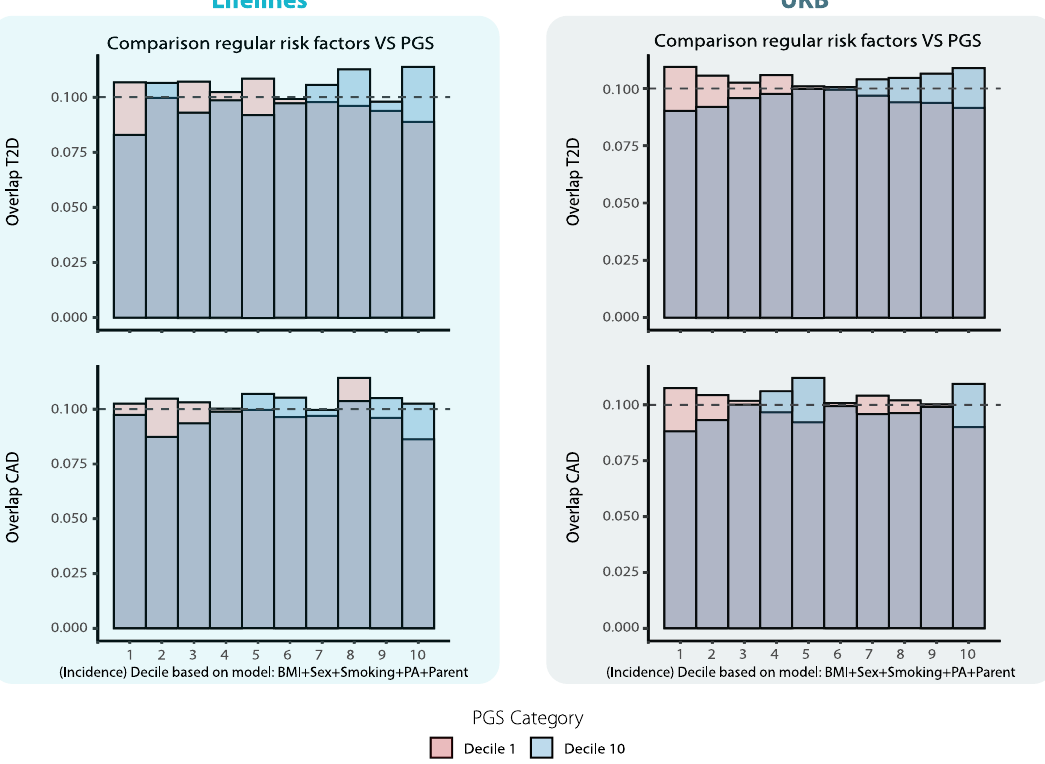
Figure 4. Comparison risk predictions based on a model based on PGS and a model based on sex, BMI, physical activity, parental T2D disease and smoking status. Each bar represents the percentage overlap of the individuals identified at high risk (10th) or low risk (1st decile) based on PGS compared to individuals identified at high risk according to questionnaire-based risk factors. Questionnaire-based risk factors identify other individuals at high risk than PGS. Dashed line indicates the overlap expected by random